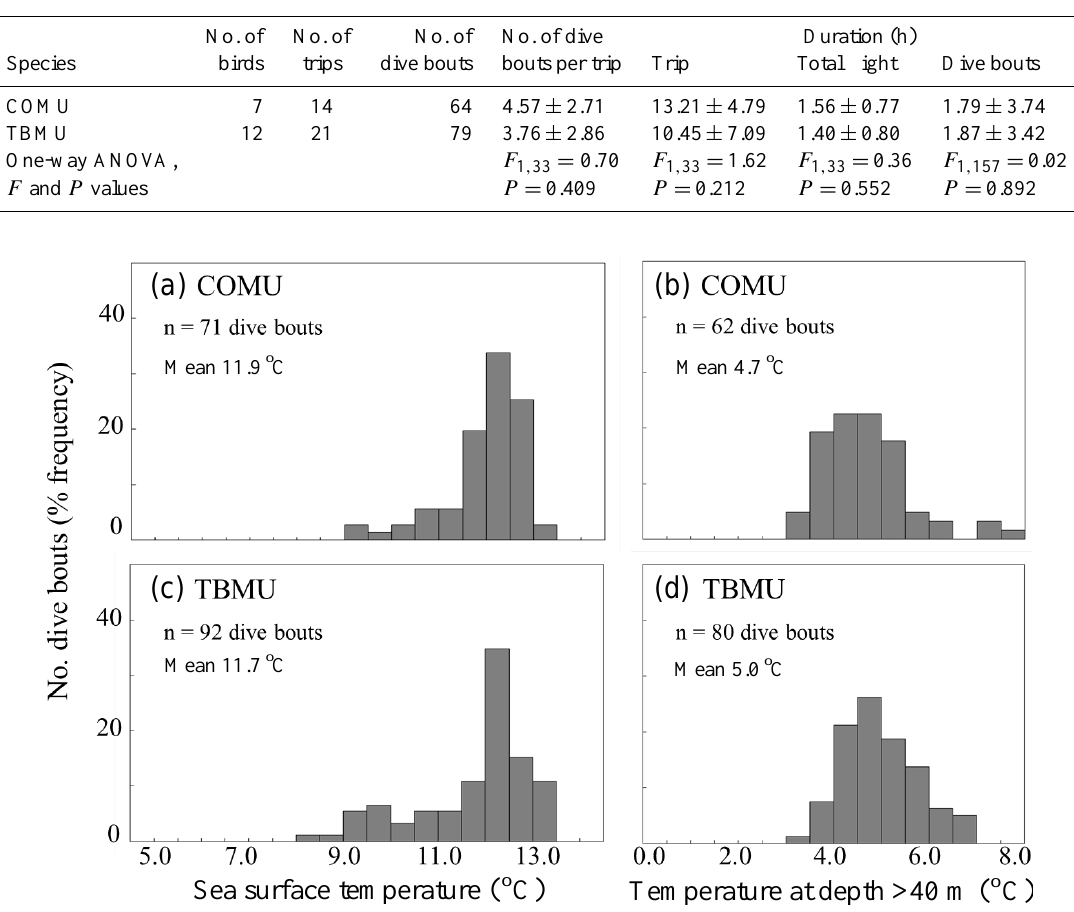
Table 1. Trip parameters of common murres (COMU) and thick-billed murres (TBMU) breeding on St. George Island, Bering Sea.